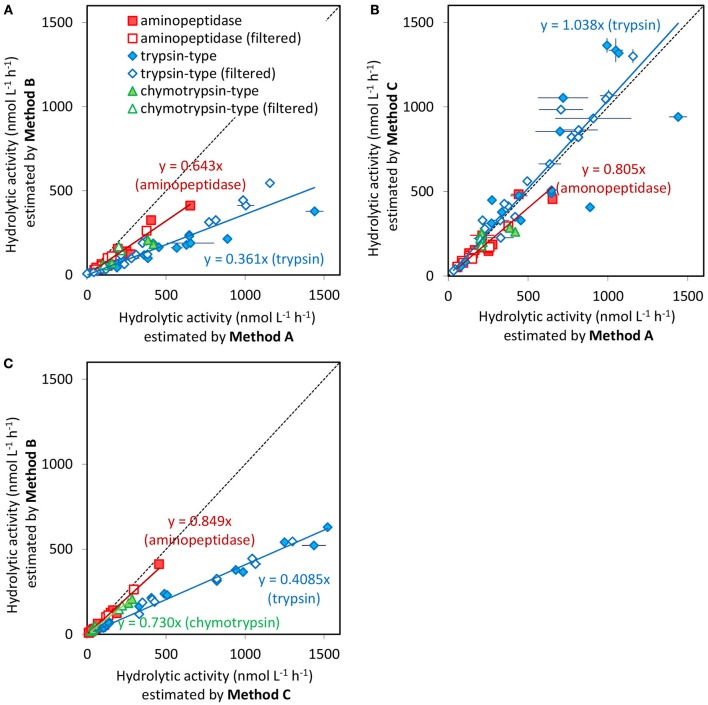
Scatter plots of hydrolytic activities measured by (A) Method A (spectrofluorometer with disposable cuvettes) and Method B (fluorometric microplate reader with regular polystyrene microplate), (B) Method A and Method C (fluorometric microplate reader with low protein binding microplate), and (C) Method C and Method B. Activities measured for all samples by each of the two methods are plotted. The shapes of symbols indicate enzymes type, and filled and opened symbols indicate unfiltered seawater samples and <0.2 μm filtered seawater (dissolved fraction), respectively. Samples from different dates are not differentiated. Error bars are the standard deviations of triplicate sample preparations. Regression lines for aminopeptidase and trypsin-type endopeptidase and their equations are also shown. These regression analyses were performed with combined dataset from unfiltered and filtered samples. Dashed line indicates 1:1.